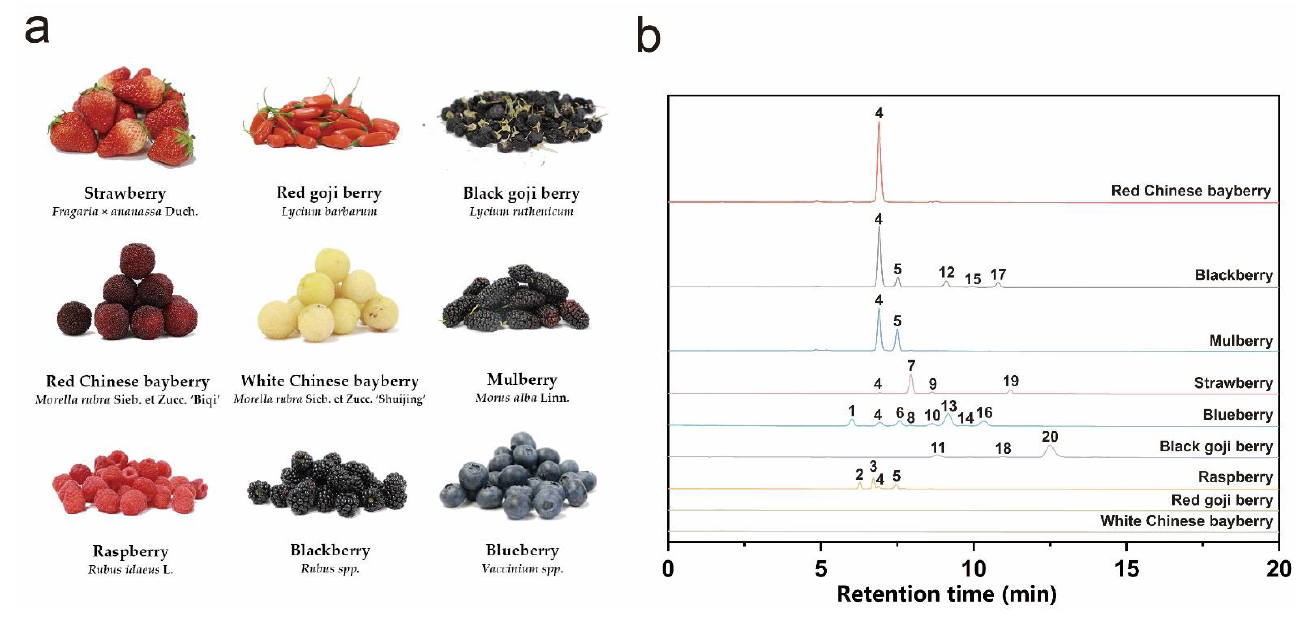
Figure 1. Fruit materials and berry anthocyanin profiles. ( a ) Berries studied in the present research. ( b ) UPLC chromatogram of anthocyanin profiles identified in different kinds of berry extract ( λ = 520 nm). These are as follows: 1: Dp-3- O -hex; 2: Cy-3- O -sop; 3: Cy-3- O -2G-glucosylrutinoside;